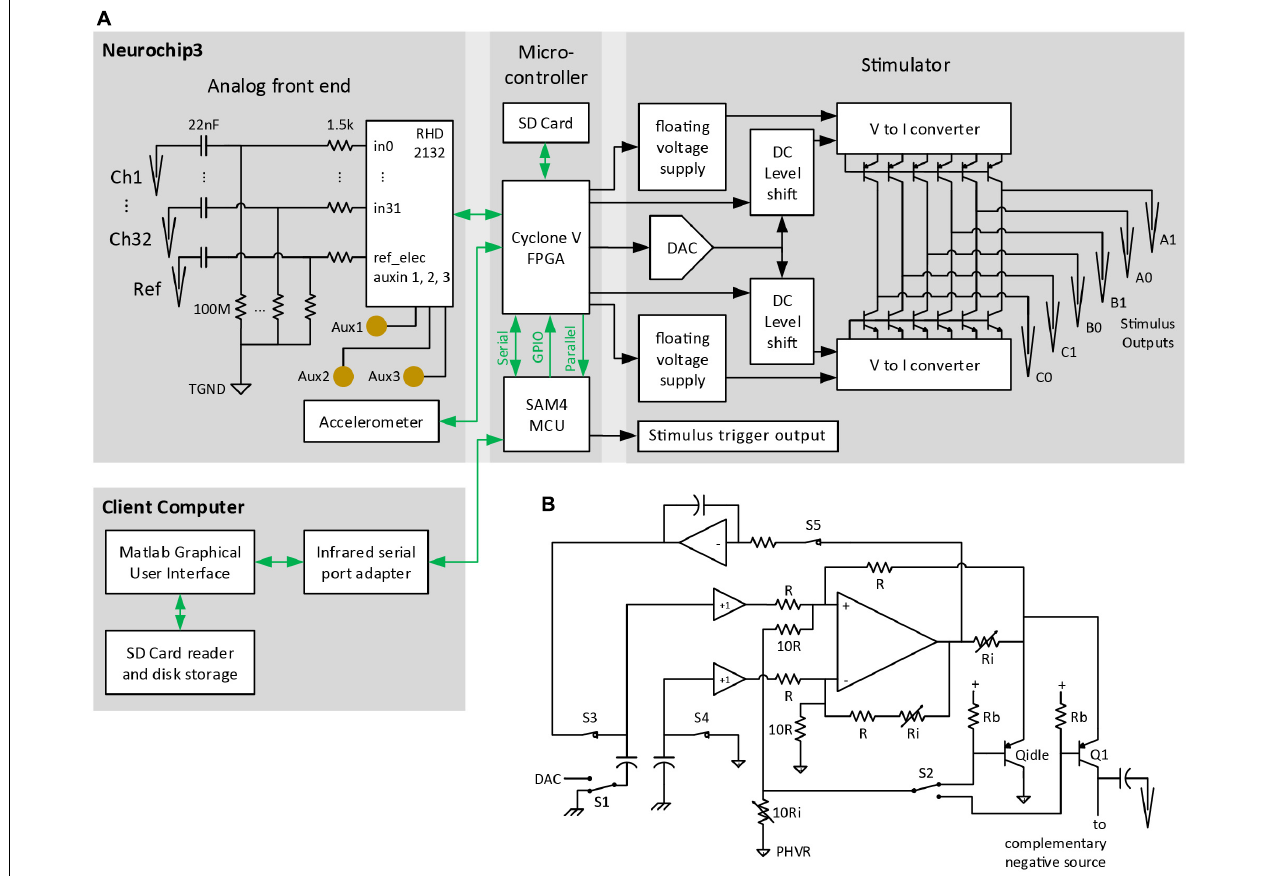
FIGURE 2 | Block diagram of major NC3 components. (A) Biophysical analog inputs pass through a 0.07-Hz high pass filter. Data from the analog front end is converted to digital format and delivered to the FPGA. Events from the MCU are relayed over GPIO pins to the FPGA where they can initiate stimulus waveforms previously setup by the MCU over a serial port. The FPGA writes data from the analog front end and MCU to a micro SD Card, and routes selected analog channels to the MCU over a parallel bus. The client computer sends settings to the NC3 over an infrared serial port, and downloads NC3 data from micro SD Cards. TGND, tissue ground; GPIO, general purpose input/output; DAC, digital-to-analog converter. (B) Circuit diagram of one of the positive “V to I converter” blocks of the stimulator. PHVR, Positive High-Voltage